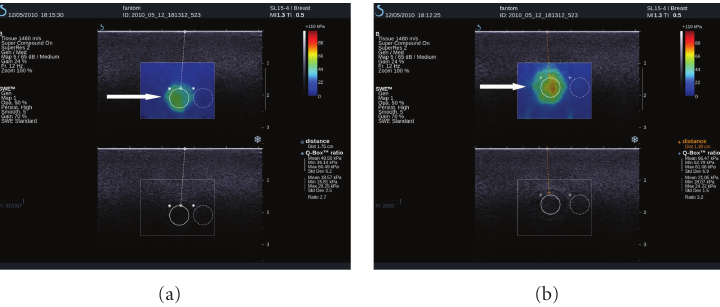
Figure 4: Phantom studies illustrating well-known physiologic phenomenon of increase of perceived tissue sti ff ness with applied increased pressure (e.g., during palpation of tissues). (a) on a breast phantom study a sti ff inclusion (arrow) is seen with no pressure applied at ultrasound probe. The distance from the surface, the sti ff ness of the inclusion and surrounding medium (dotted circle) can be measured. (b) with application of pressure on the phantom with ultrasound probe, which is evident as a reduced distance of the inclusion to the surface of the phantom, the sti ff ness of the inclusion and surrounding medium is increased. Thus, the measurements of sti ff ness of tissues with supersonic shear wave elastography should be performed in a resting state without pressure on the ultrasound probe to avoid the unpredictable influence of the compression on the sti ff ness of the